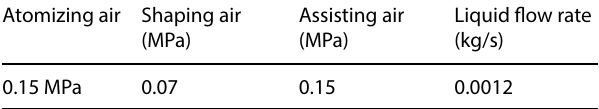
Table 1 Application parameters used in the simulations